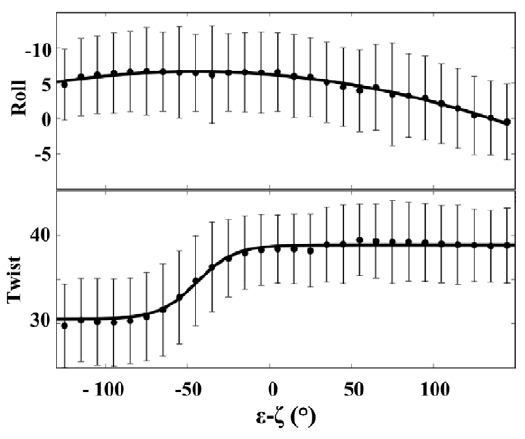
Figure 7. Changes in inter-base pair parameters as a function of ( e - f ) values. The C 21 p 22 A 22 average values of roll ( u ) and twist ( u ) and their standard deviations (bars) are plotted as a function of the ( e - f ) values of p 22 , considering S0–S3. Mg 2 + -mediated enhancement of the BII population of p 22 leads to an increase in the proportion of conformations characterized by negative rolls and high twists.